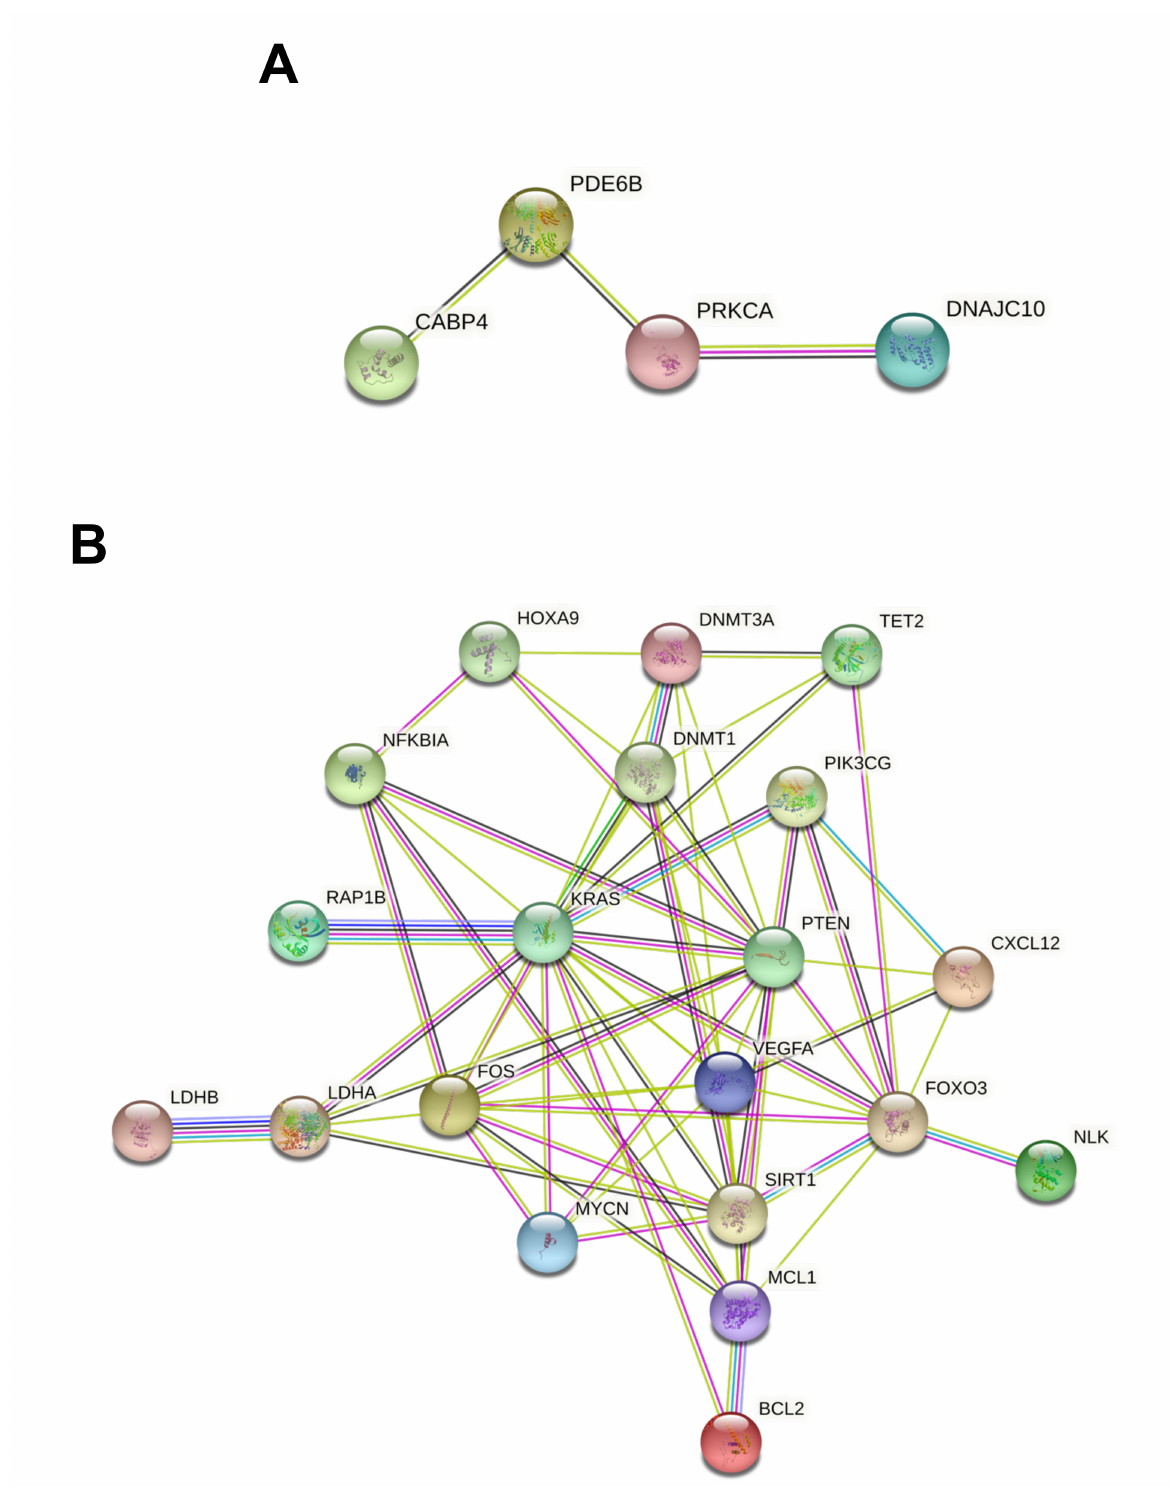
Figure 5. ( A ) STRING PPI network observed for the 12 genes altered by the five up-regulated miRNAs after pesticide exposure; ( B ) STRING PPI network observed for the 22 genes altered by the seven up-regulated miRNAs after pesticide